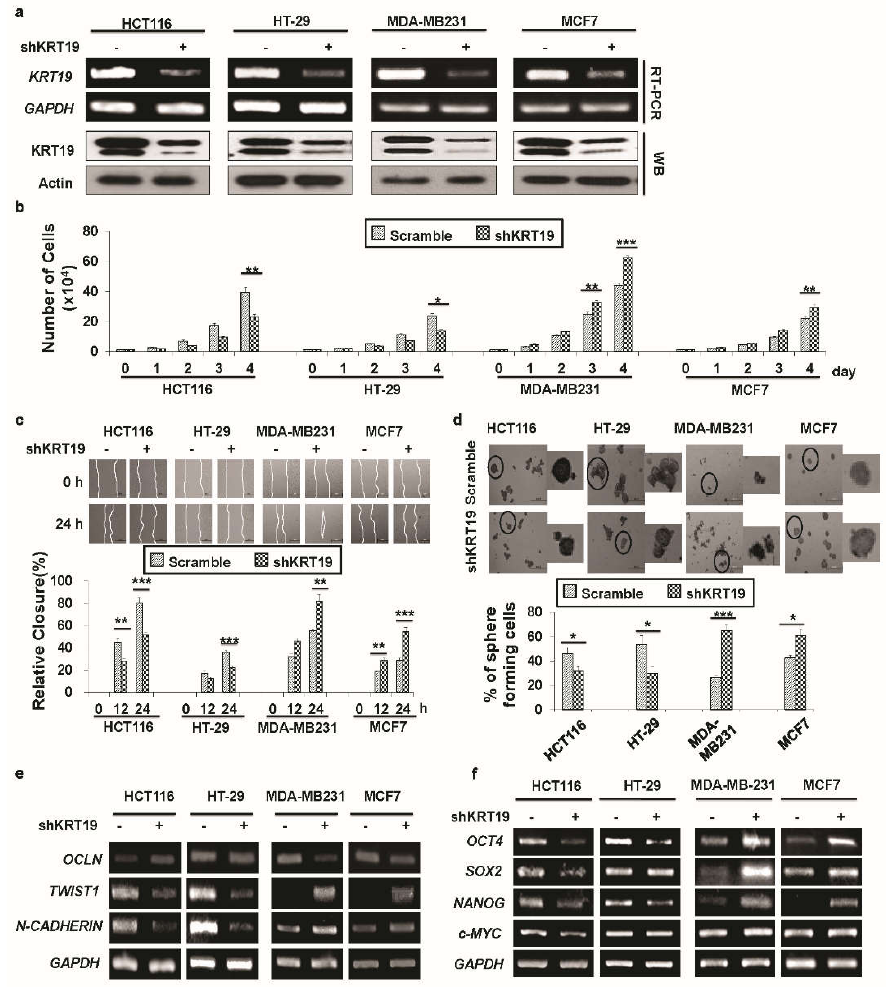
Figure 2. Effect of KRT19 knockdown on colon and breast cancer proliferation, migration, and sphere formation. ( a ) KRT19 expression in scramble and shKRT19 cells was analyzed by RT-PCR and Western blotting in the indicated cancer cell lines. GAPDH /actin was used as a loading control. ( b ) Proliferation of the indicated cells analyzed by trypan blue cell counting. Cells were enumerated up to 4 days. ( c ) Wound healing migration assay used to assess the migration capacity of the indicated cells. Cell migration was observed at the indicated time point and is shown as percent (%) enclosure. Photos were taken under an inverted light microscope. Scale Bar: 500 µ m. ( d ) Cell sphere formation assay performed in the non-coated culture dish. Spheres were enumerated after 5 days of culture with crystal violet then photos were taken under an inverted light microscope. The black circular areas in the left panel photos were enlarged in the right panel, and data are presented as percent (%) of sphere forming cells. Scale Bar: 500 µ m. ( e ) RT-PCR analysis of the epithelial-mesenchymal transition (EMT) and mesenchymal-epithelial transition (MET) markers. ( f ) mRNA expression of stemness markers analyzed by RT-PCR. Each experiment was repeated at least three times, and data are represented as means ± SDs (* p < 0.05, ** p < 0.01, *** p <